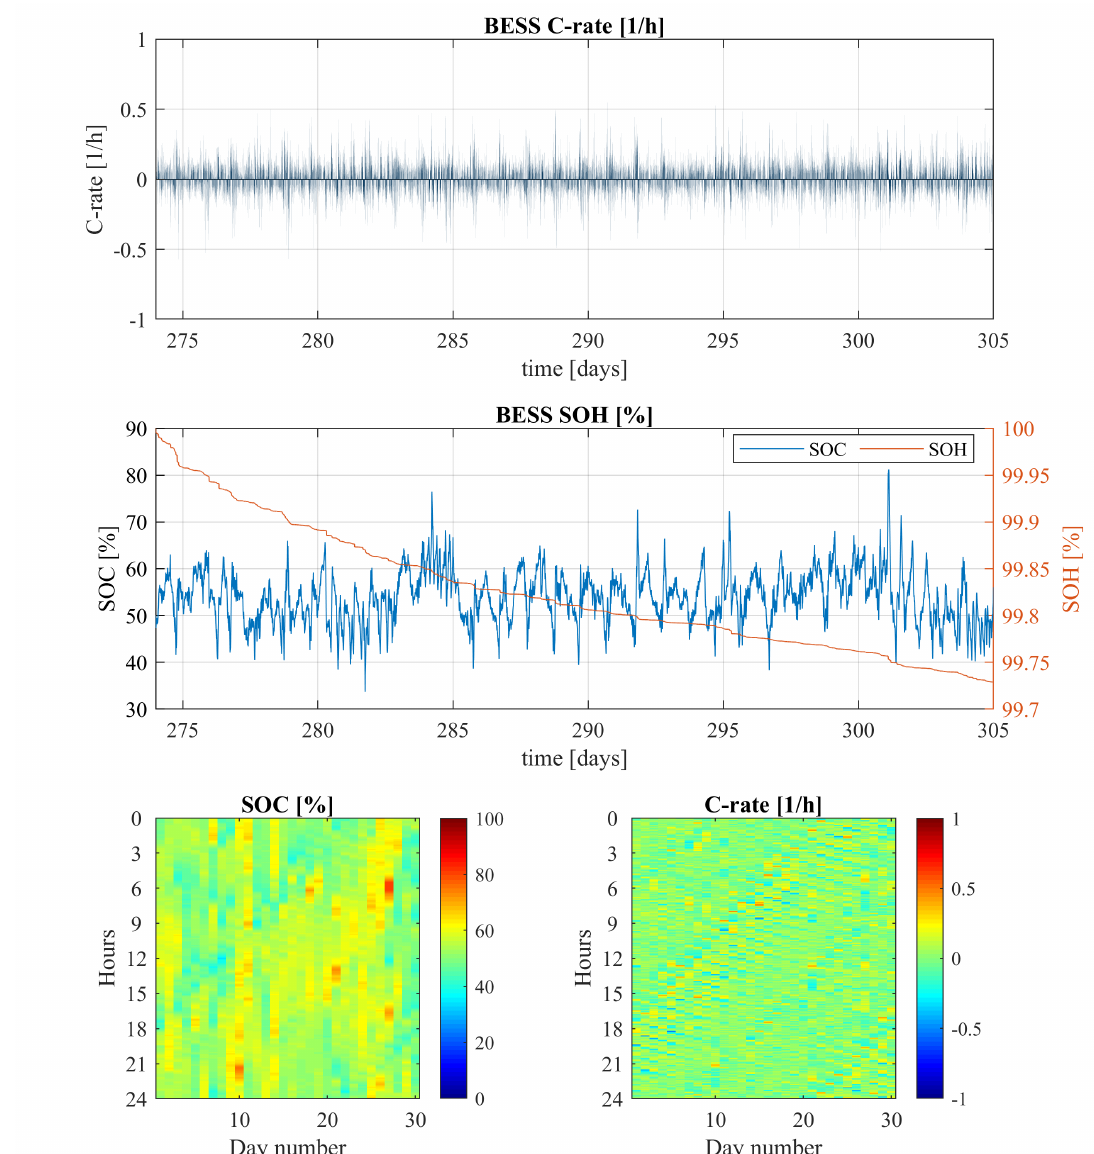
Figure A4. SimSES modelling of a 30 day PCR operation. The battery model is set to the lithium-iron-phosphate (LFP) cathode chemistry, and ageing is limited to cycle ageing solely.